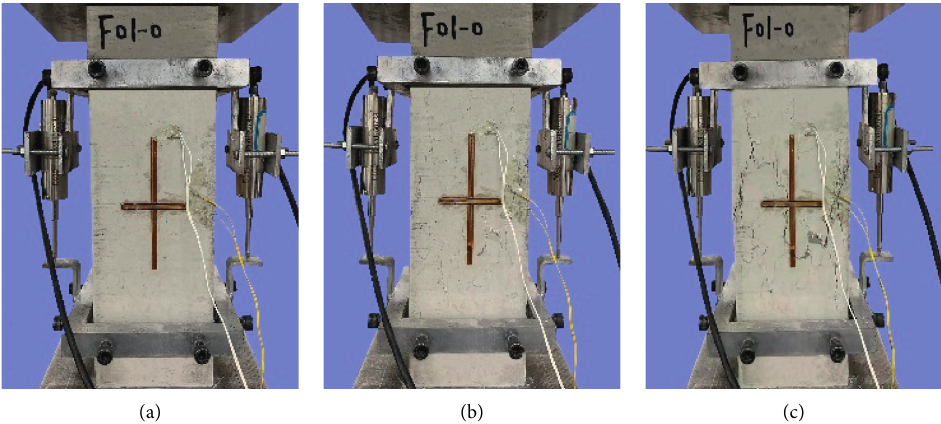
Figure 6: Failure pictures of OC F01 at different loading stages. (a) Initial loading. (b) 0.8 ∼ 0.9 f